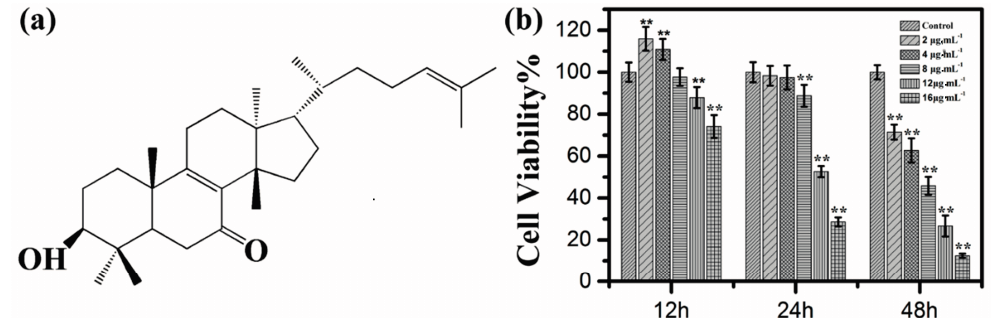
Figure 1. ( a ) Molecule structure of kansenone; ( b ) In vitro cell toxicity experiments. Relative cell viabilities of IEC-6 cells after incubation with various concentrations of kansenone for 12, 24 and 48 h, respectively. Compared with corresponding control group, ** p <